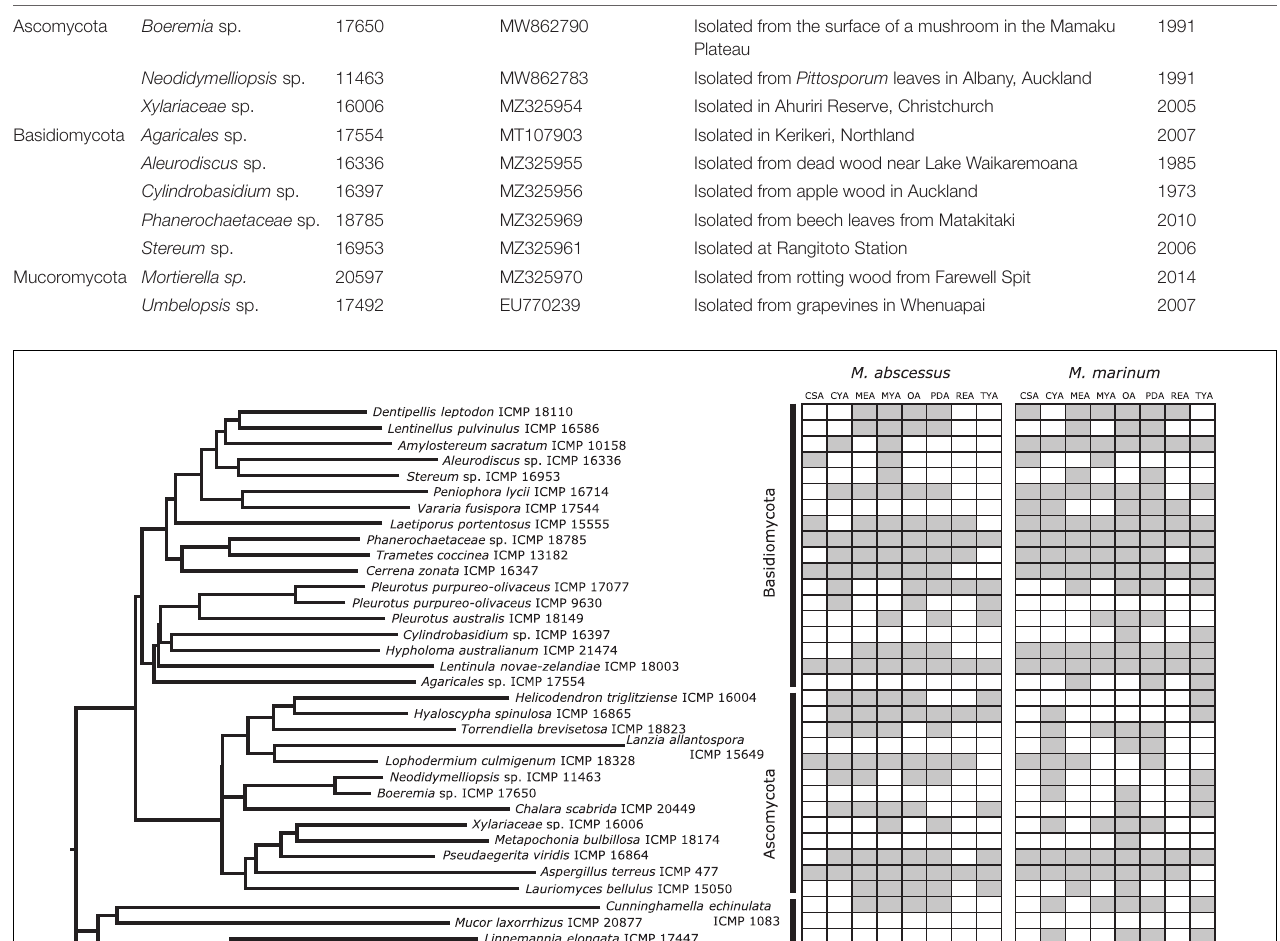
FIGURE 2 | Phylogeny and activity of ICMP isolates grown in different media against M. abscessus BSG301 and M. marinum BSG101. Active media for each isolate are shown in gray. CSA, Czapek Solution Agar; CYA, Czapek Yeast extract Agar; MEA, Malt Extract Agar; MYA, Malt Yeast extract Agar; OA, Oatmeal Agar;